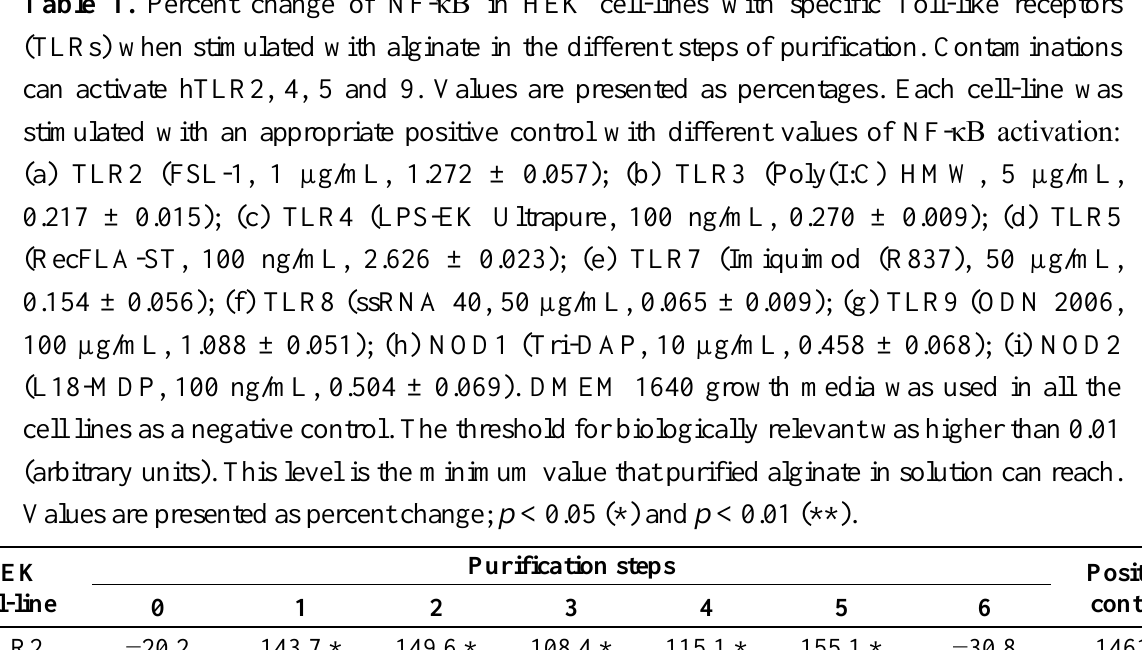
Table 1. Percent change of NF-κB in HEK cell-lines with specific Toll-like receptors (TLRs) when stimulated with alginate in the different steps of purification. Contaminations can activate hTLR2, 4, 5 and 9. Values are presented as percentages. Each cell-line was stimulated with an appropriate positive control with different values of NF-κB